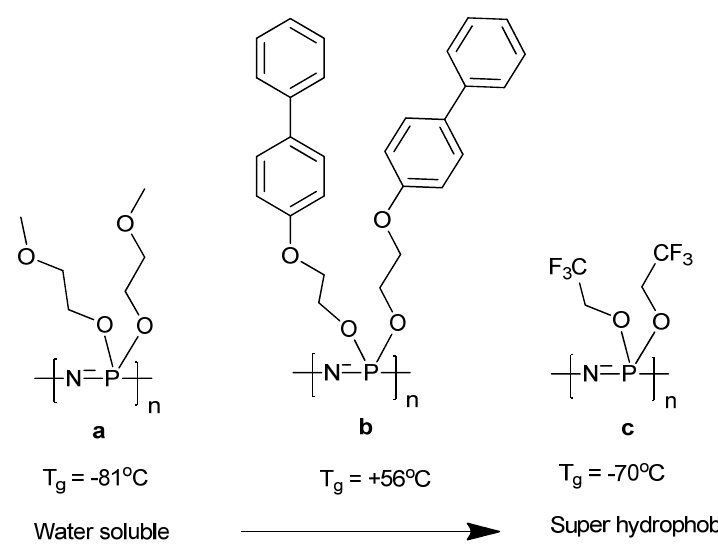
Figure 2. Some examples of poly[(organo)phosphazenes] with varied properties. (T values as reported in g